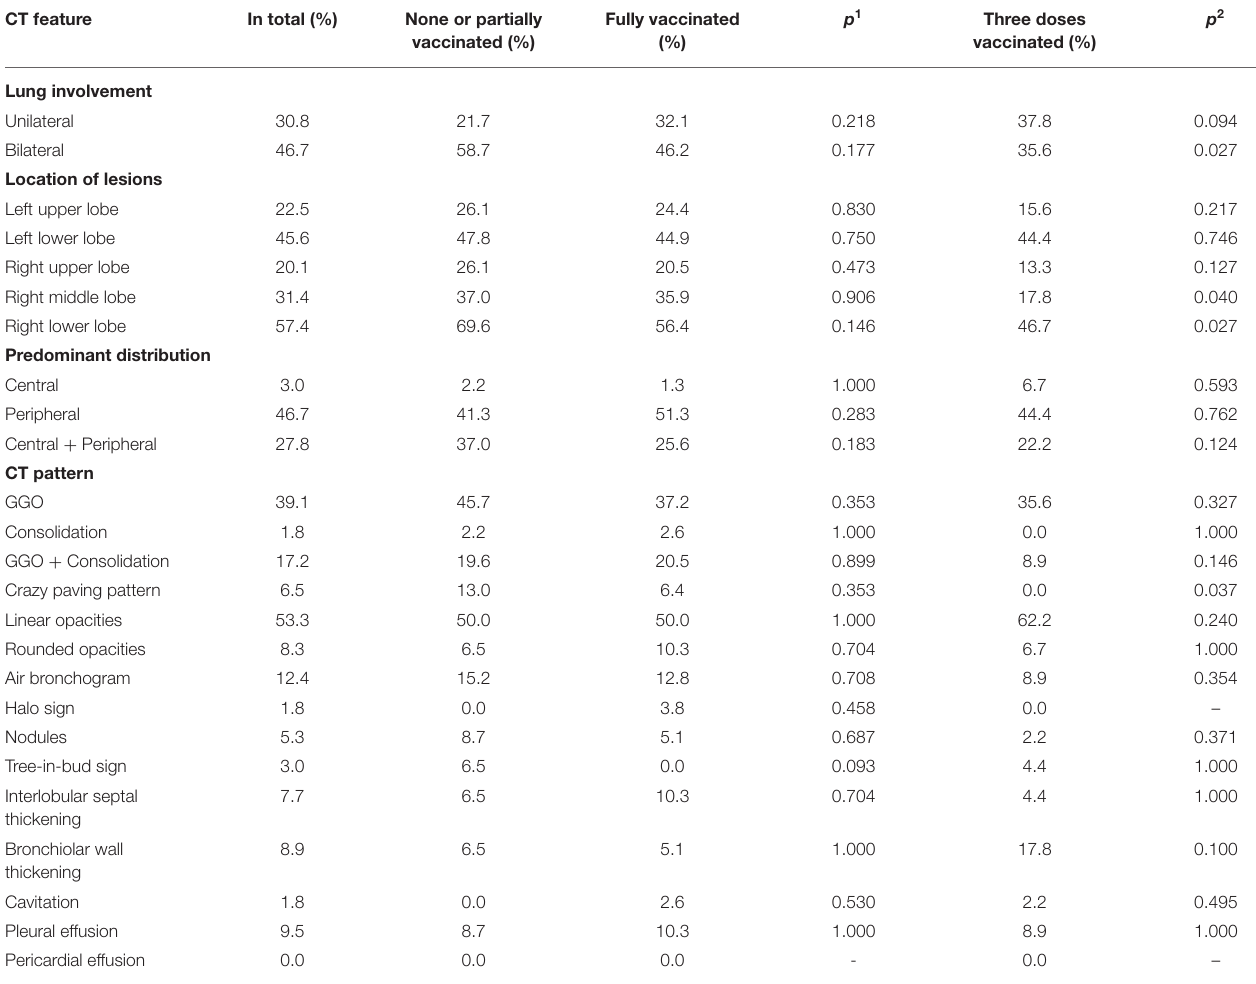
TABLE 4 | The CT features of COVID-19 patients infected by the omicron variant were divided into three subgroups as indicated. CT